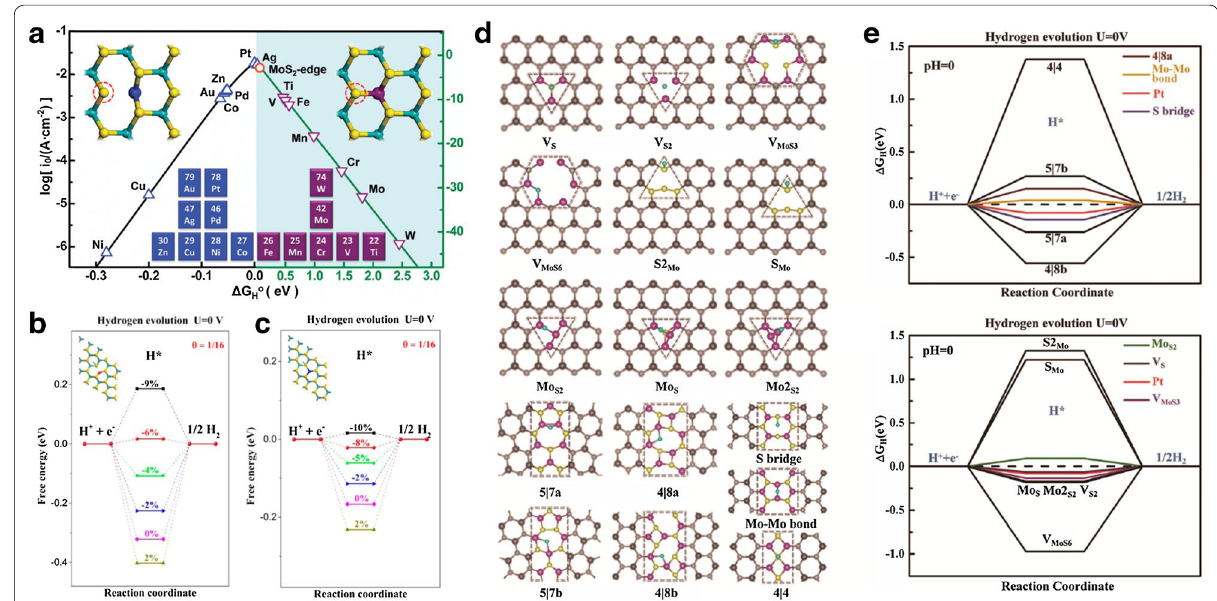
Fig. 4 a The volcano-shaped relationship between the (log(i 0 )) and ∆ G H . Free energy diagram for the HER on b Rh-doped MoS 2 , and c Ag-doped MoS